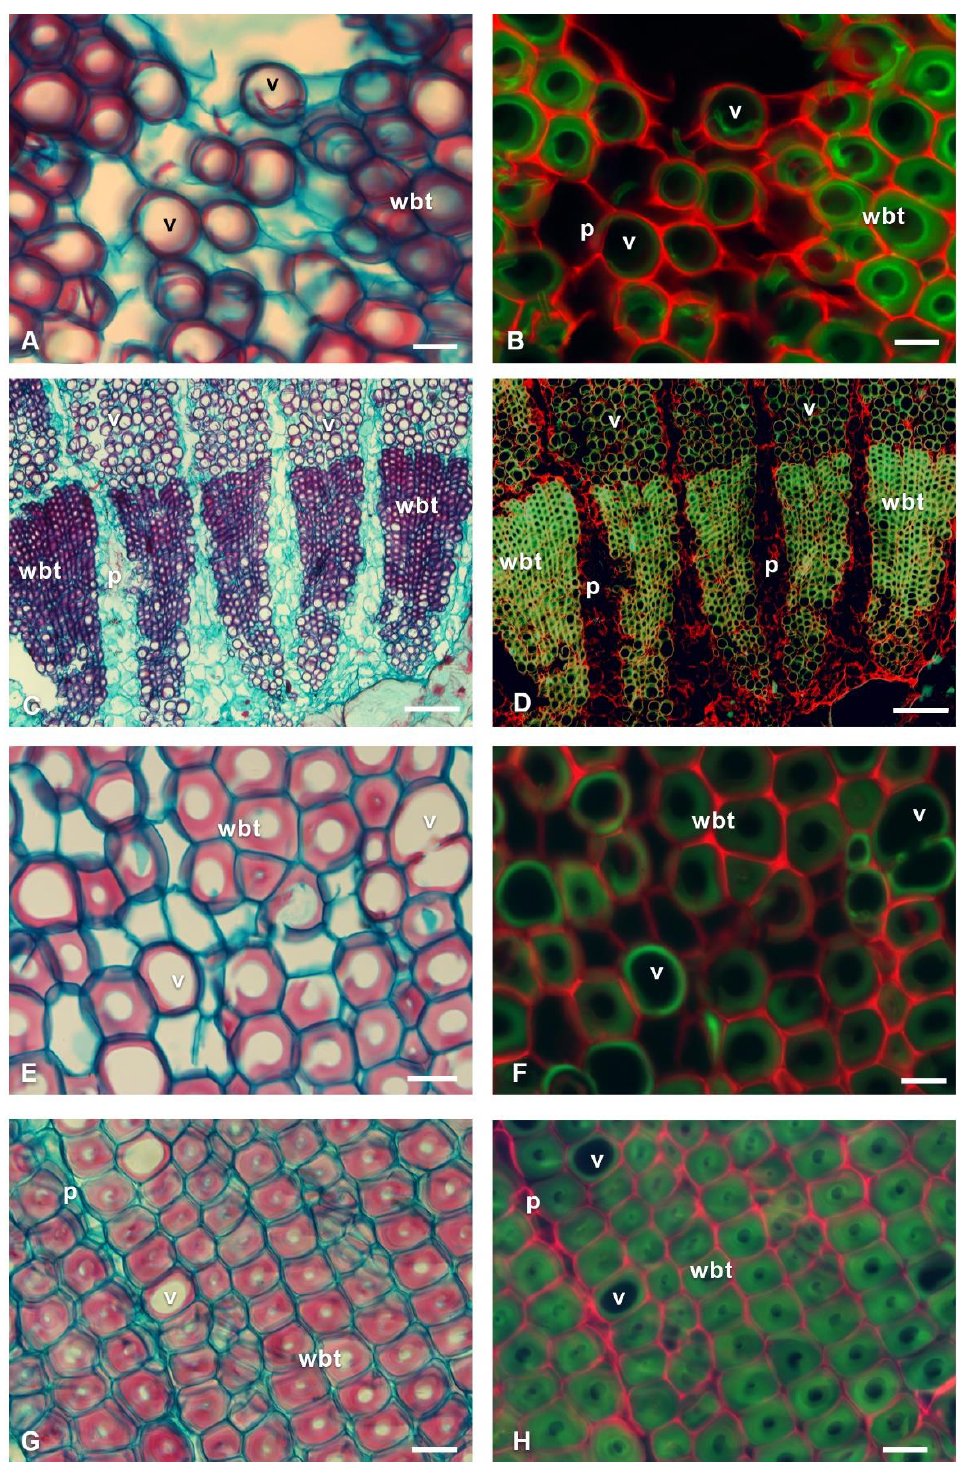
Figure 5. Fluorescence emission of transverse sections of non-fibrous wood species of Cactaceae. ( A , B ) Coryphantha clavata . ( C , D ) Echinocereus cinerascens . ( E , F ) Mammillaria dixathocentron . ( G , H ) Neolloydia conoidea . p = parenchyma, v = vessel, wbt = wide-band tracheids. Scale: 20 µm: A,B,E,H; 200 µm: C,D.